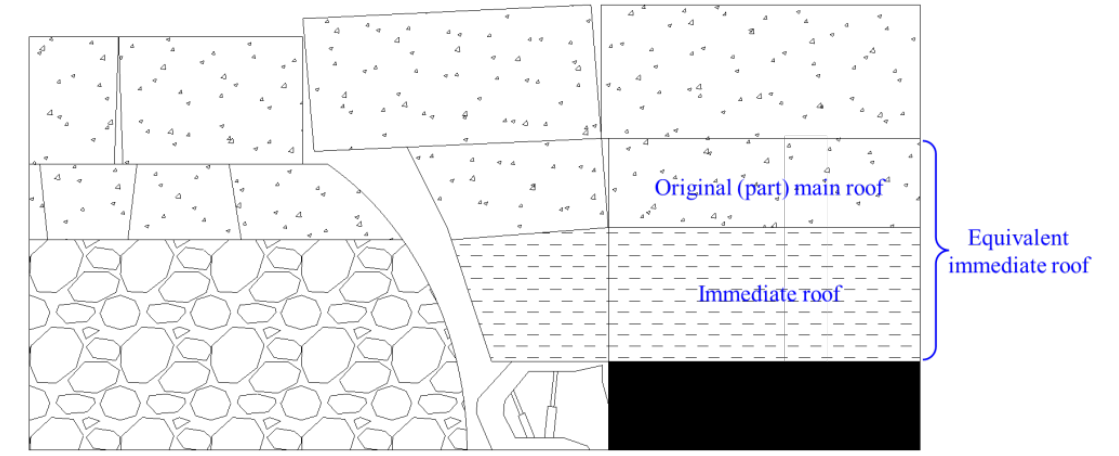
Figure 2. Schematic diagram of equivalent immediate roof of ultra-large height mining face. The equilibrium state of the in situ stress field in the rock mass is destroyed after